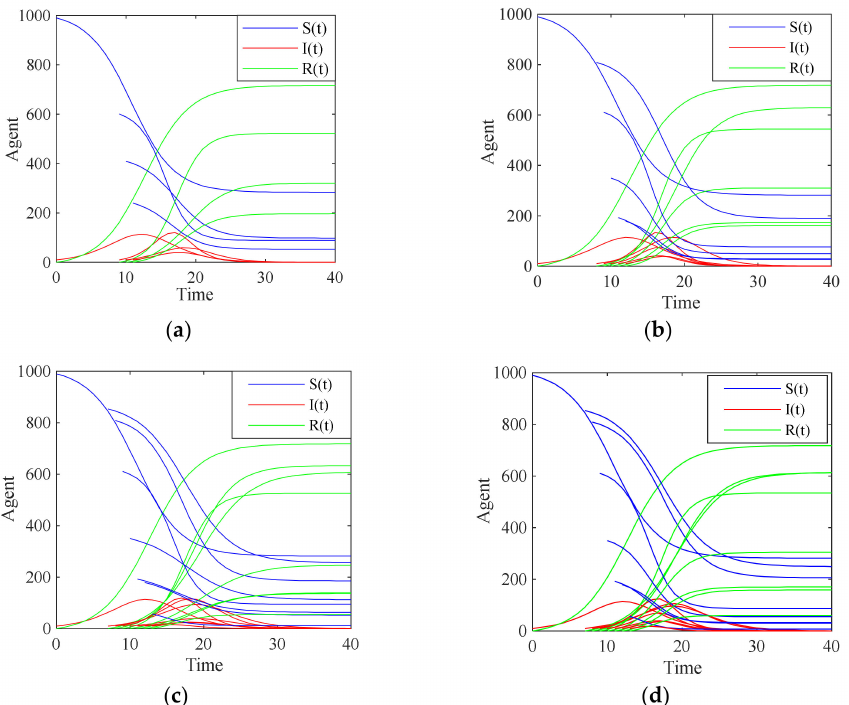
Figure 15. Evolution of initial public opinion and subtopics under different environmental